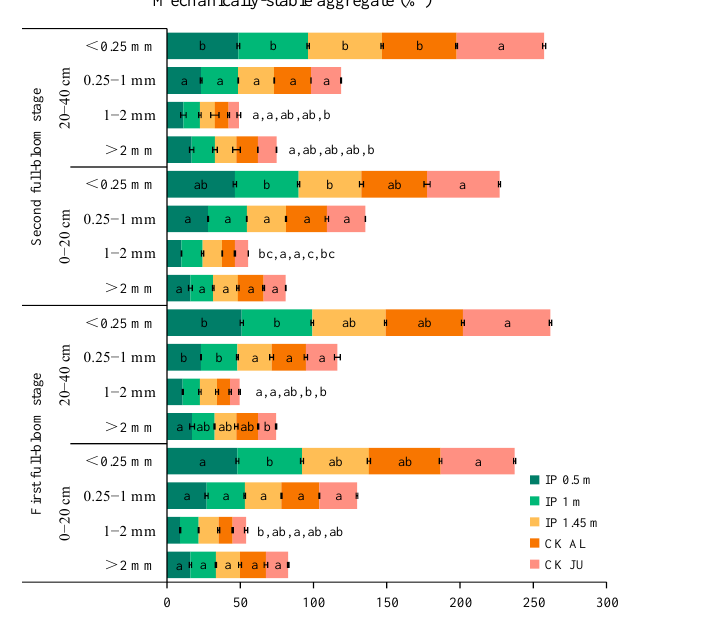
Figure 3. Distributions of soil mechanically stable aggregates (SMSA) for soil samples taken at the two depths during the first and second full-bloom stages. The letters for each bar segment denote the significant differences between the treatments at a given size of the aggregate.